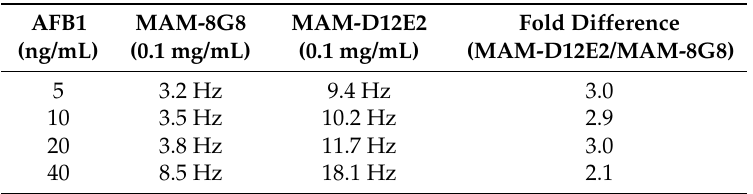
Figure 3. Inhibitory AFB1 analysis with MAM-8G8 and MAM-D12E2 antibodies using AFB1 immobilized sensor chip (0–40 ng/mL AFB1). Error bars represent the standard errors. Table 2. The frequency difference between control and competition samples for MAM-8G8 and MAM-D12E2.